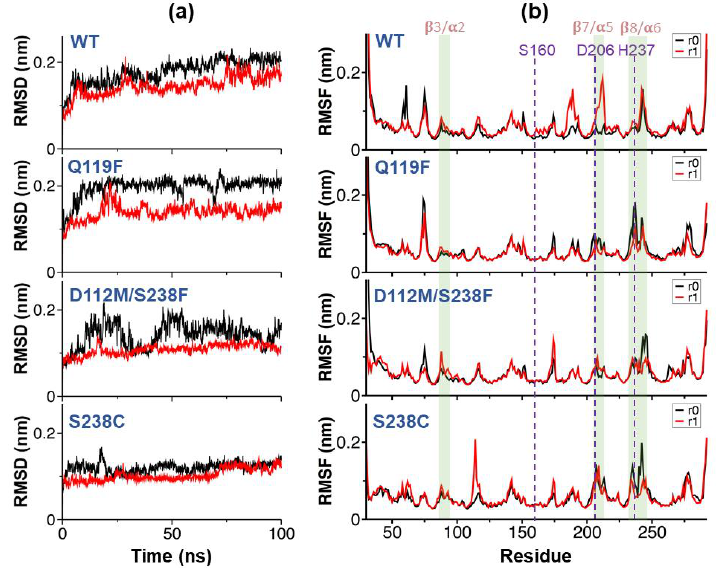
Figure 6. Simulations and conformational analysis. ( a ) Root-mean-square deviation (RMSD) of the proteins during the course of 100 ns NPT simulations compared with their starting structures based on the crystallographic data. The RMSD results of WT, Q119F, D112M/S238F, and S238C were indicated with two replicas “r0” (black line) and “r1” (red line). ( b ) Per-residue root-mean-square-fluctuation (RMSF) calculated from the last 50 ns of all trajectories. The RMSF results of WT, Q119F, D112M/S238F, and S238C were indicated with two replicas “r0” (black line) and “r1” (red line). The green shadows represented regions β 3/ α 2, β 7/ α 5, and β 8/ α 6 of